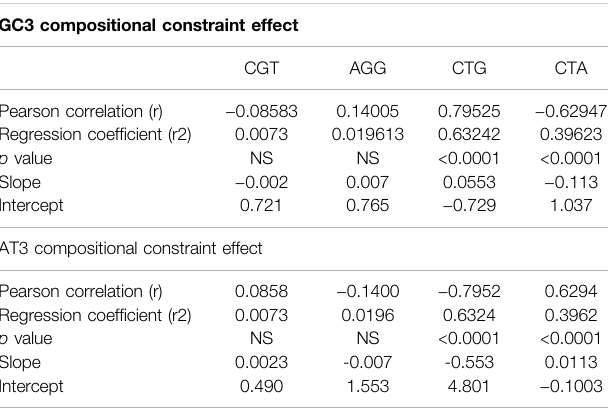
TABLE 4 | Effect of compositional constraints on selective codons.